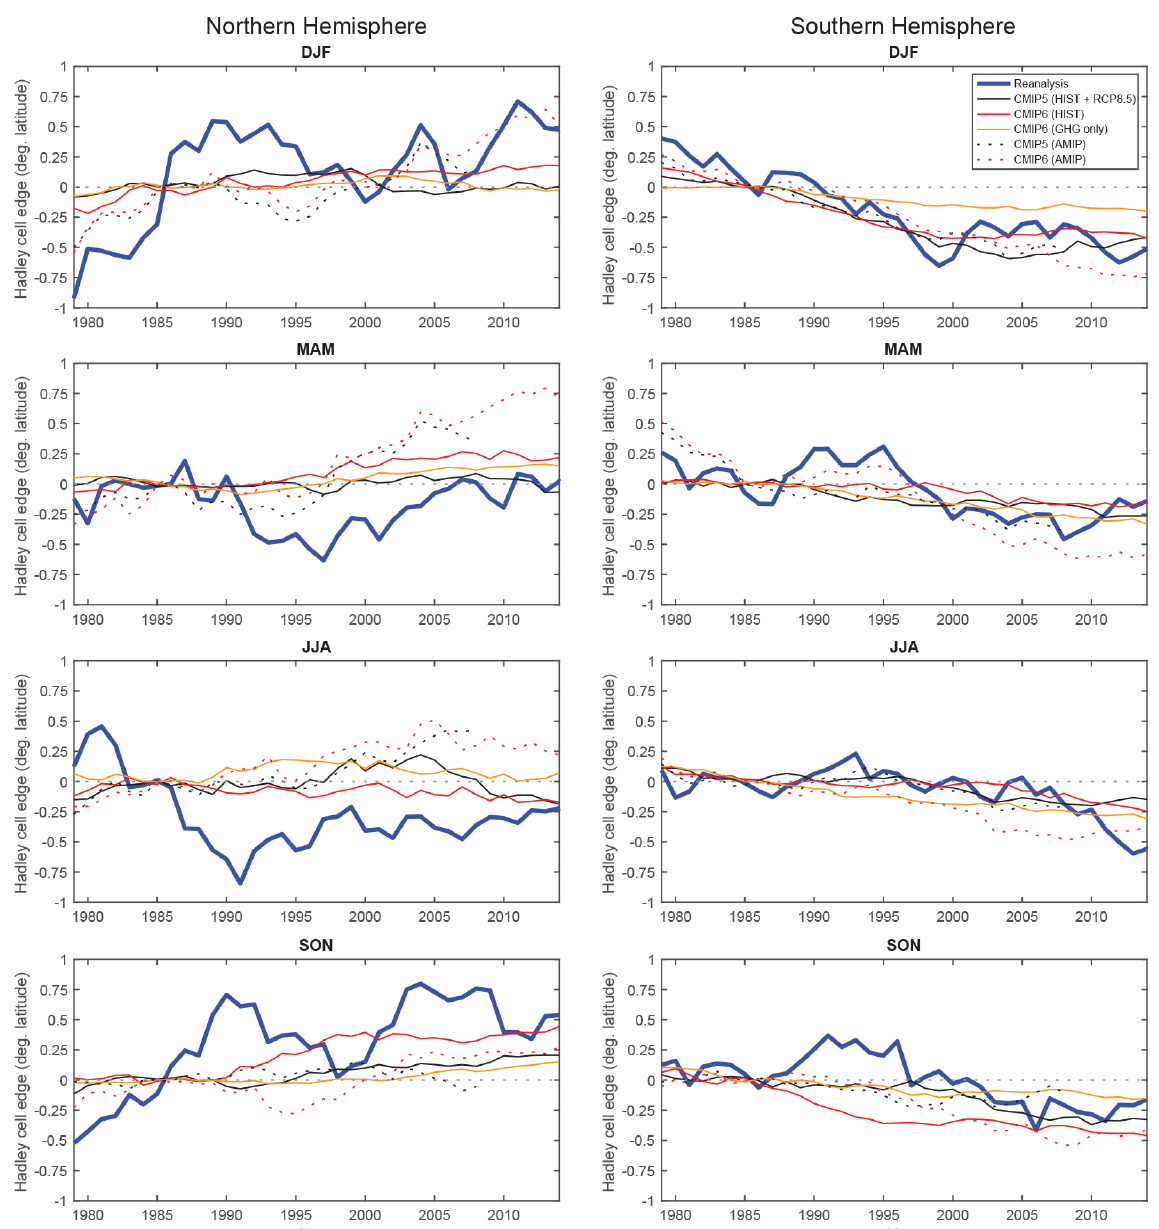
Figure 8. As in Fig. 5, but for time series of 1979–2014 seasonal-mean Hadley cell edge latitudes (as measured by USFC metric) in both